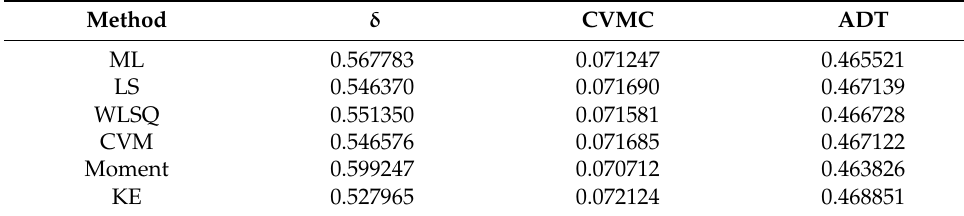
Table 5. p -values for comparing methods under the survival